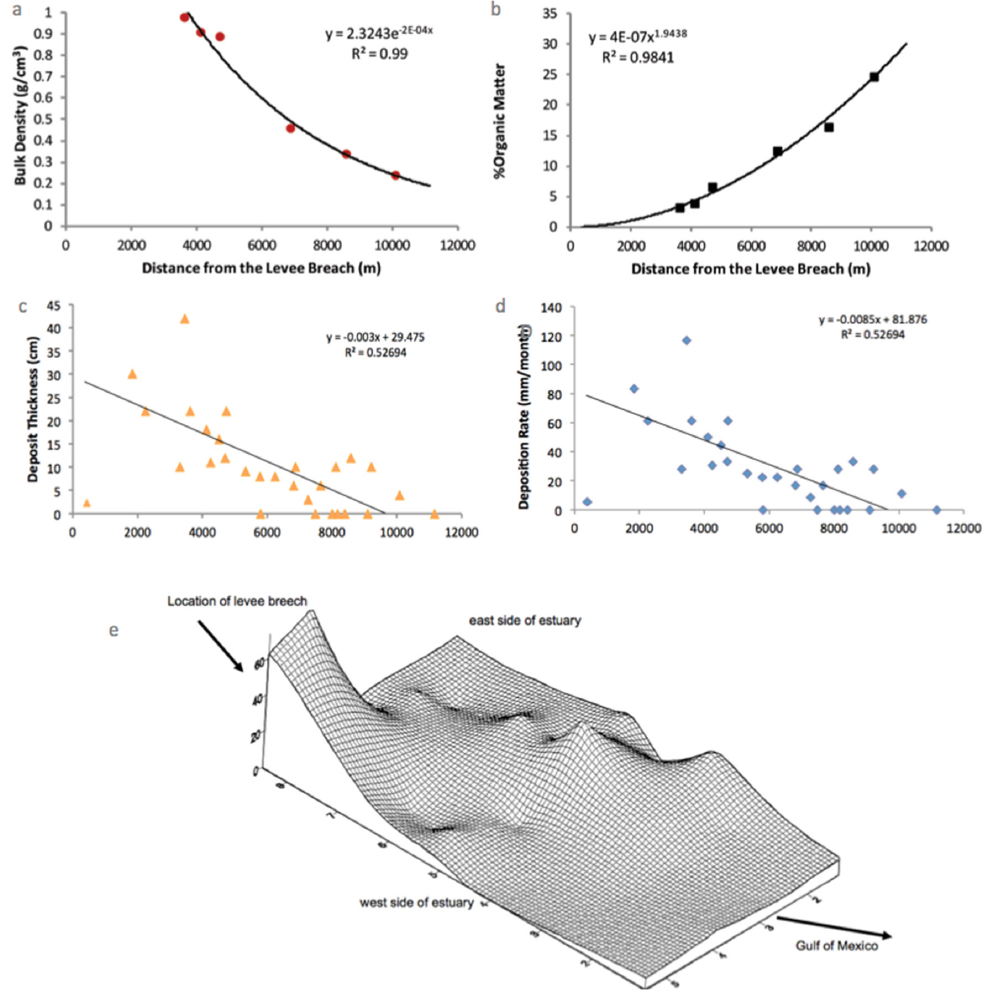
Figure 3. With distance from the levee breach are shown ( a ) dry bulk density; ( b ) organic matter content (%); ( c ) thickness (cm) of the silty-clay layer; ( d ) deposition rate (mm·month − 1 ) for 6 cores; ( e ) the crevasse splay deposit based on measurements of silty-clay layer, which has area of 130 km 2 .